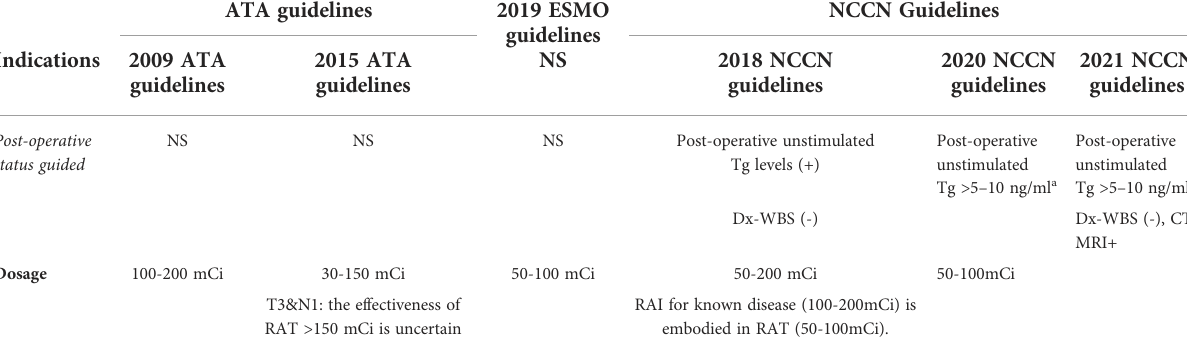
TABLE 4 Post-operative status guided RAT through